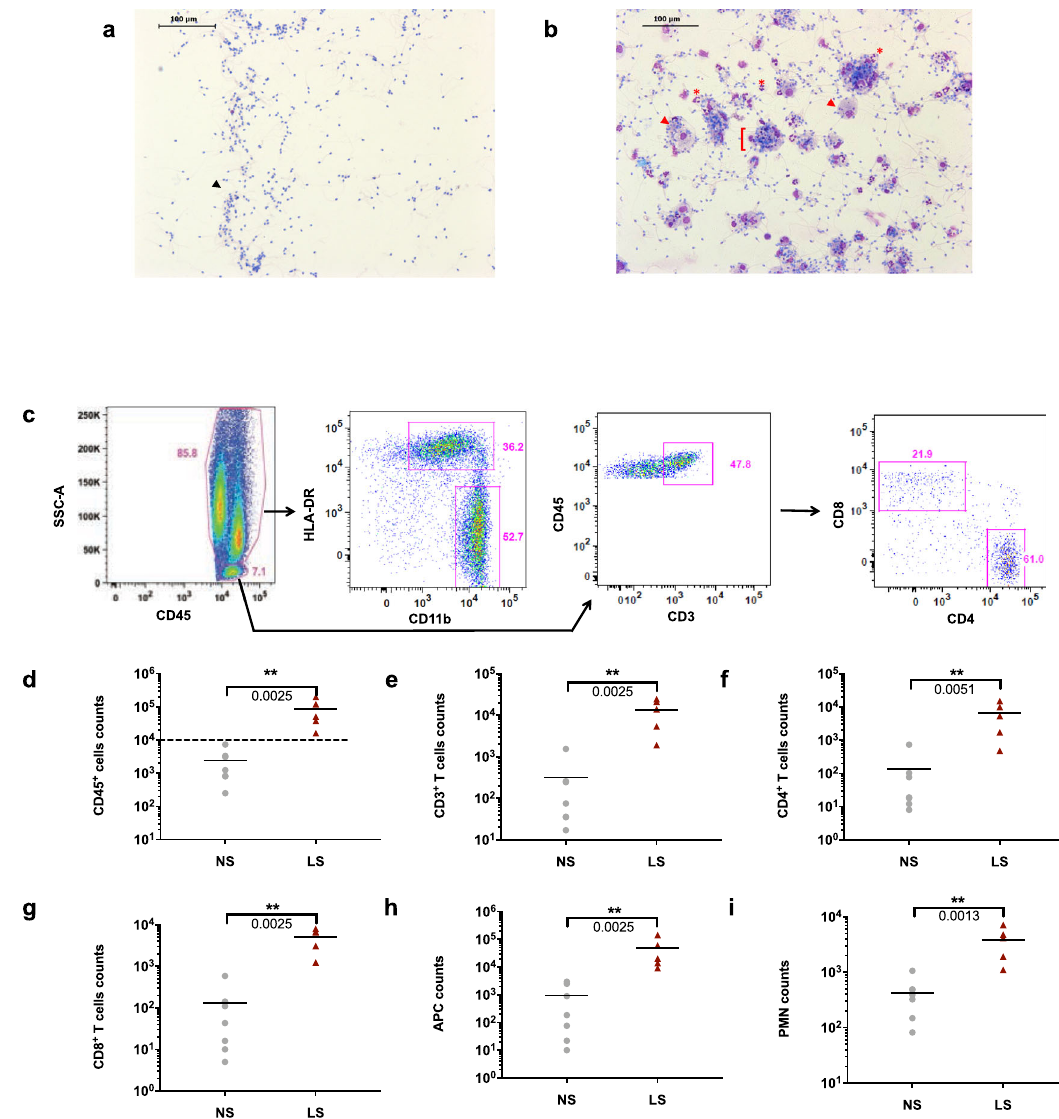
Fig. 1 Characterization of normal and leukocytospermic semen of uninfected macaques. a , b Representative immunocytochemical staining of cells from a normal semen (NS) and b leukocytospermic semen (LS). Numerous spermatozoa (black arrowhead) were present in NS. LS was rich in white blood cells, including lymphocytes (black *), macrophages (red arrowhead) and neutrophils (red *), frequently forming aggregates ([) with spermatozoa. c Gating strategy for semen leukocyte characterization. After the exclusion of doublets, cell debris, and dead cells, leukocytes are identi fi ed with the pan-leukocyte marker CD45. The SSC-A versus CD45 gate distinguishes lymphocytes from macrophages and polymorphonuclear cells on the basis of morphology. CD11b and HLA-DR distinguish HLA-DR bright CD11b mid-to-bright antigen-presenting cells (APC) from CD11b bright HLA-DR neg-to-low polymorphonuclear (PMN) cells. CD3 + T cells are gated against CD45 and CD4 + T cells are separated from CD8 + T cells. d – i Number of events acquired by fl ow cytometry per sample, as all collected semen cells were analyzed for NS ( n = 7) and LS ( n = 5): d CD45 + cells, e CD3 + lymphocytes, f CD4 + T cells, g CD8 + T cells, h APC, and i PMN. The dotted line in panels ( d ) represents the leukocytospermia threshold (10,000 CD45 + events acquired). The mean is shown. Statistical signi fi cance between groups was tested using Wilcoxon rank-sum tests, ** p <